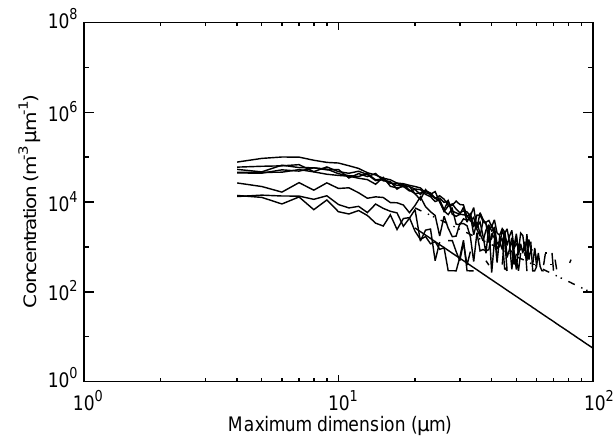
Fig. 2. Size distributions in a cirrostratus cloud measured on 15 October 1992 over southern Germany. The eight curves represent eight di(cid:128)erent parts of the cloud and thereby give a measure of the natural variability. The two lines represent parameterizations for particles larger than 20 (cid:108) m for (cid:255) 55 (cid:14) C ( solid ) and (cid:255) 40 (cid:14) C ( dash - three dots ) after Heymsfield and